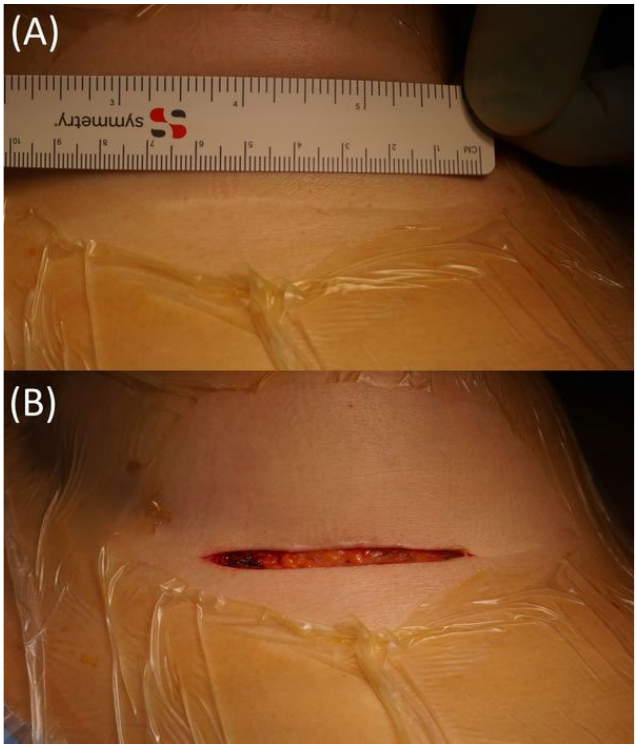
Figure 1: A: Inframmary scar from the breast augmentation. B: surgical